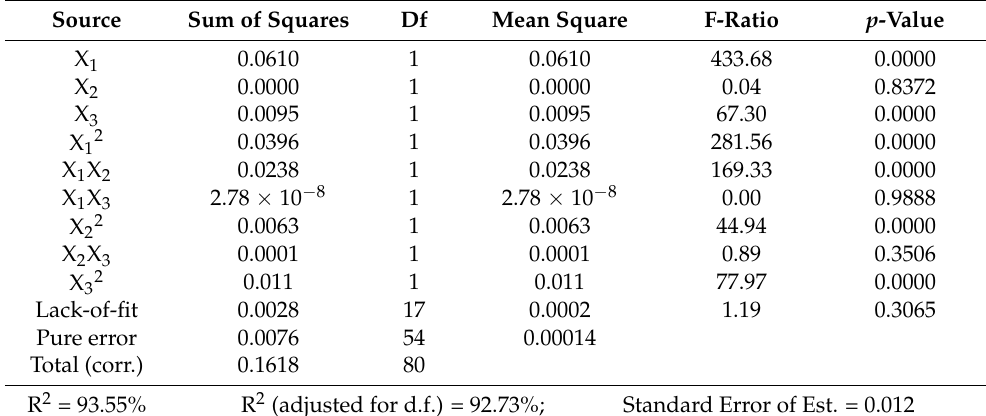
Table 3. ANOVA for the response surface quadratic model for foam